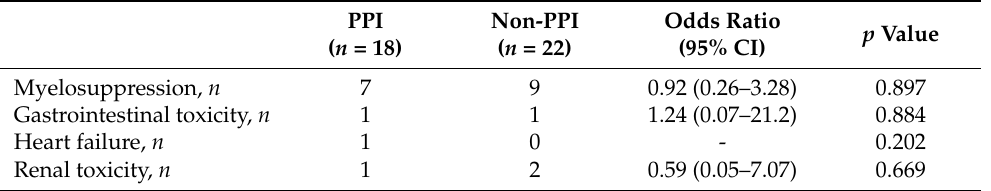
Table 4. Chemotherapy-related adverse events (grade ≥ 3) for esophageal cancer patients taking PPIs vs. patients without PPI